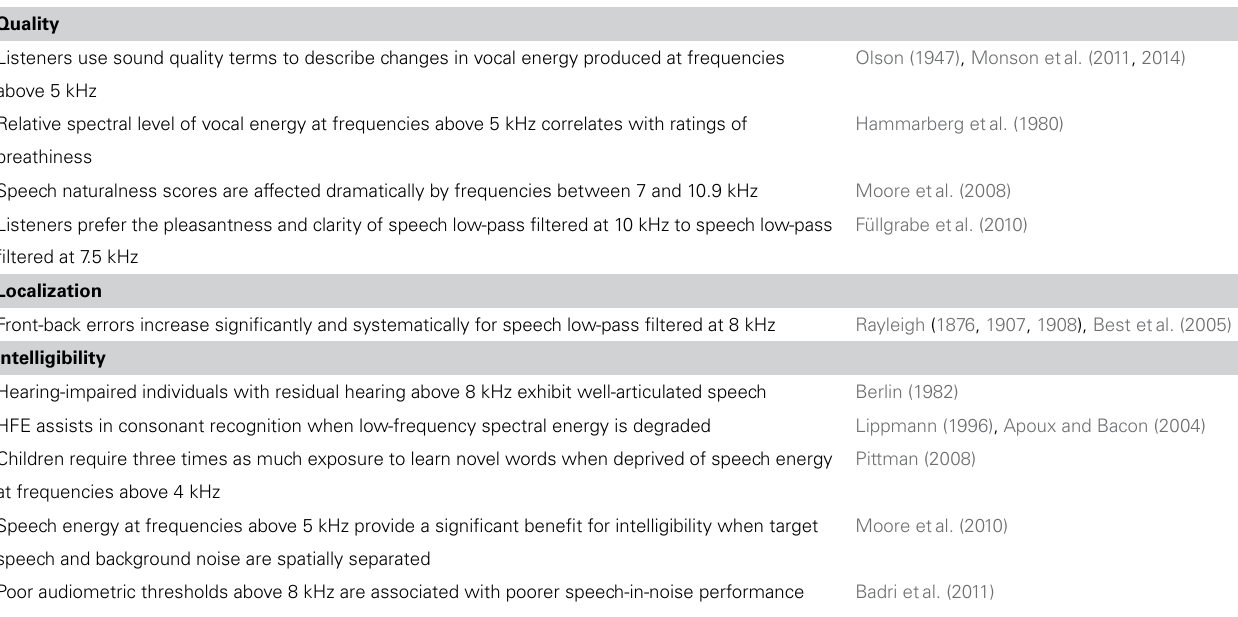
Table 2 | Summary of evidence for the perceptual importance of HFE.